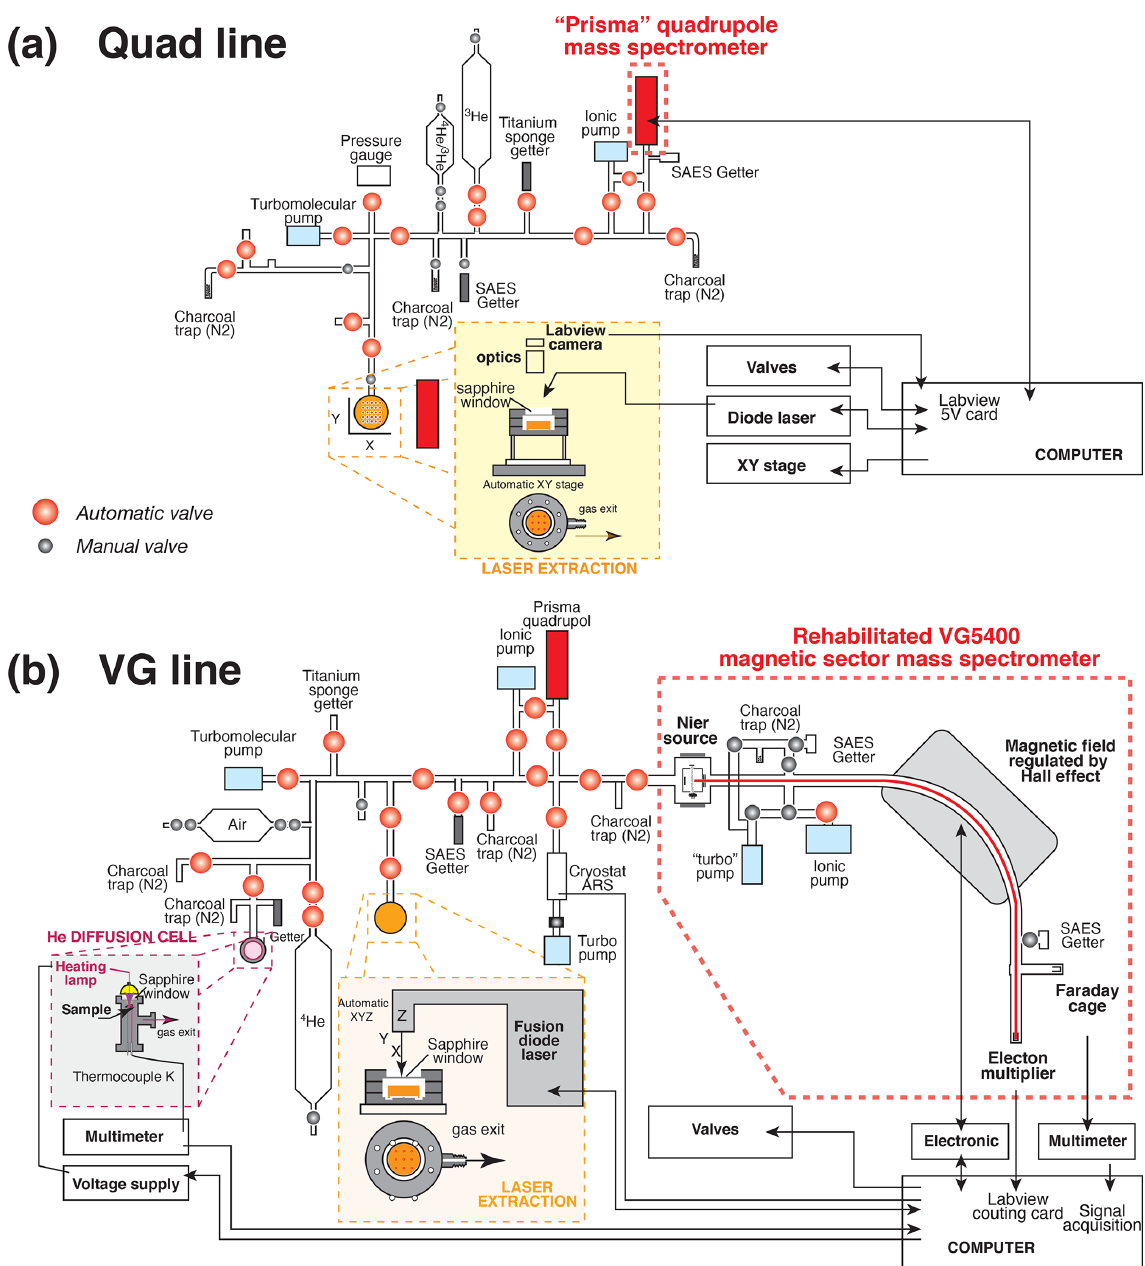
Figure 1. Schematic representation of the built-in-house systems for He extraction, purification, and analysis by a mass spectrometer: (a) quad line and (b) VG line. The part with the He diffusion cell in panel (b) is not used in this